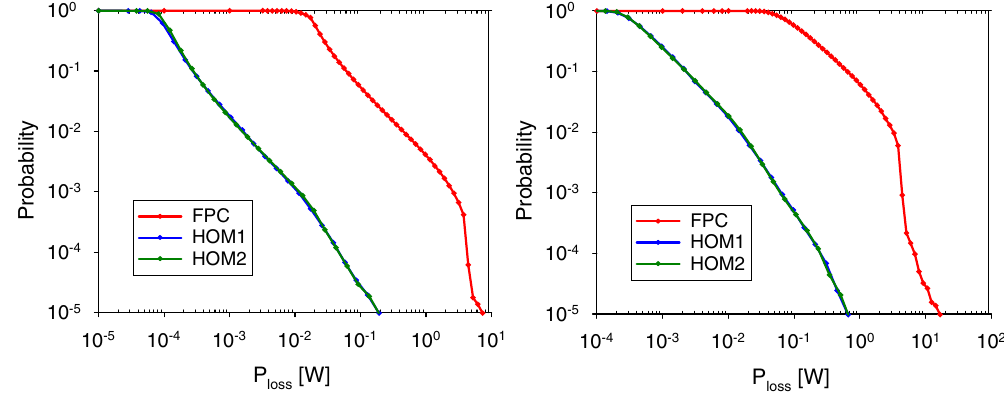
FIG. 14. Cumulative probability of HOM power radiation through coupler ports in the single 3.9 GHz cavity (left) and in the third- harmonic section (right) of the LCLS-II linac.